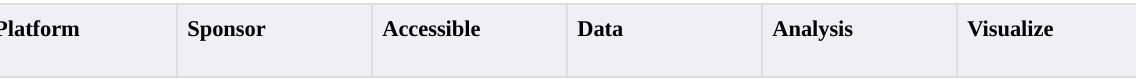
Table 1. Existing urban observatories and data